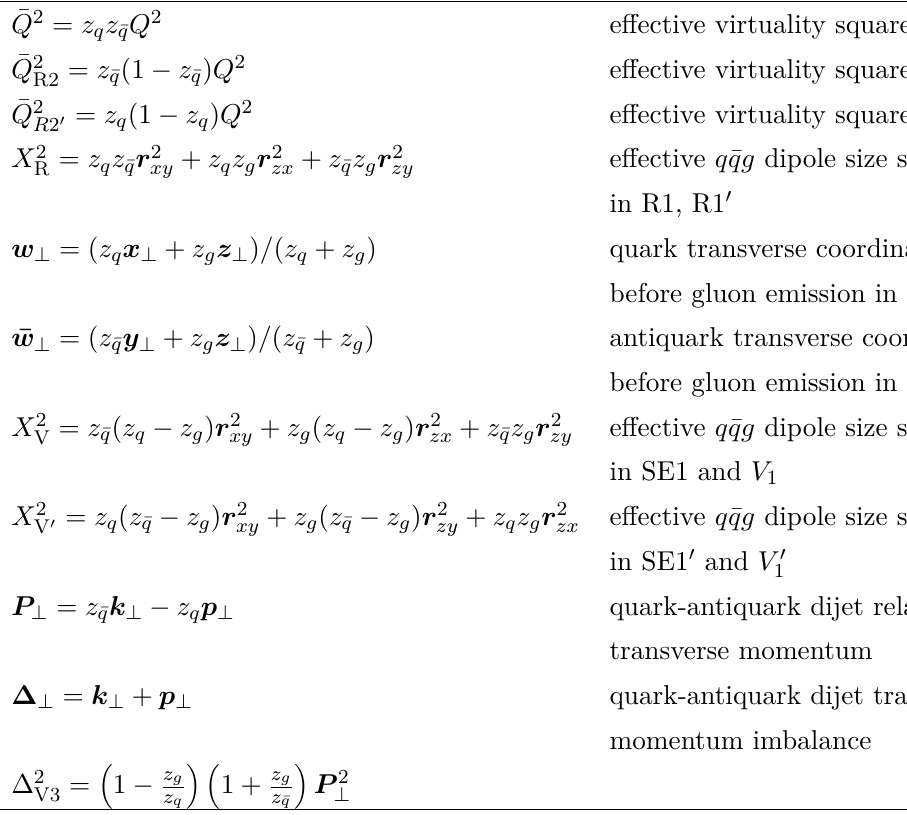
Table 4 . Notations for the longitudinal DIS inclusive dijet